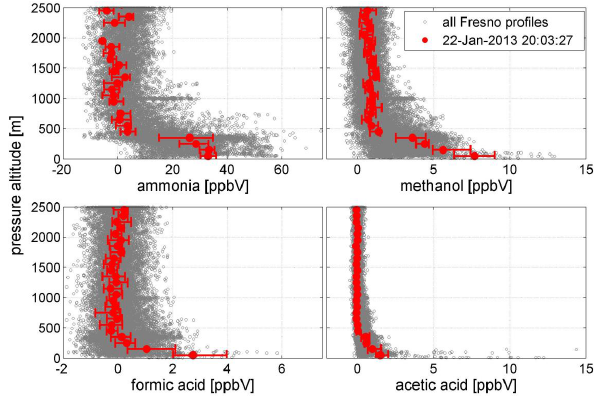
Figure 10. Vertical profiles of methanol, acetic acid, ammonia and formic acid as obtained during the NASA DISCOVER-AQ mission in January and February 2013 over Fresno, CA, USA. Grey dots include data from all flights, red dots refer to data from a single profile (100 m bins, median with upper and lower quartile) measured on January 22, 2013 started at 20:03 (UTC).